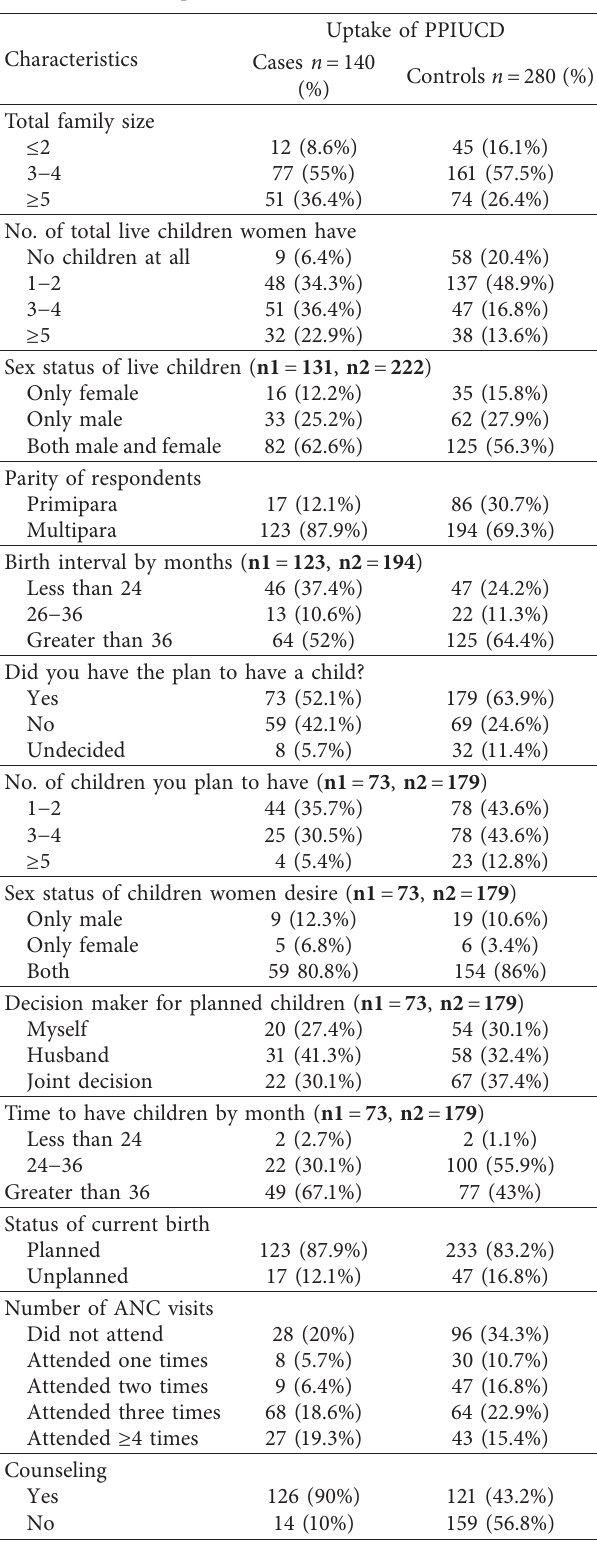
Table 2: Obstetric, reproductive, and maternal health-care char- acteristics of respondents delivering in public hospitals of South Gondar zone, Ethiopia, 2019 ( n � 140 cases and 280